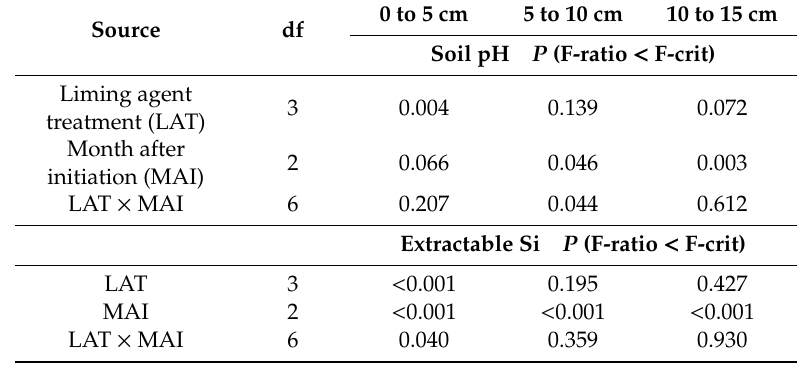
Table 2. ANOVA of creeping bentgrass fairway soil pH (1:1) and 0.5 M acetic acid extractable silicon level, by soil depth and source.